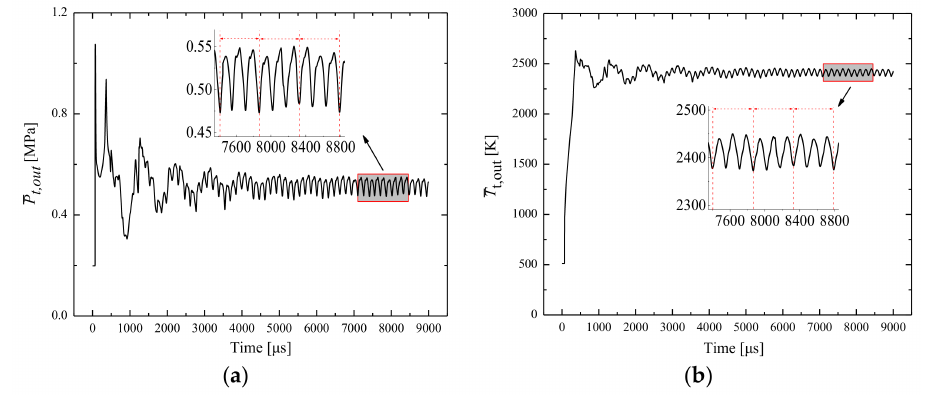
Figure 5. Variations of ( a ) P t , out and ( b ) T t , out , with time in the CRD